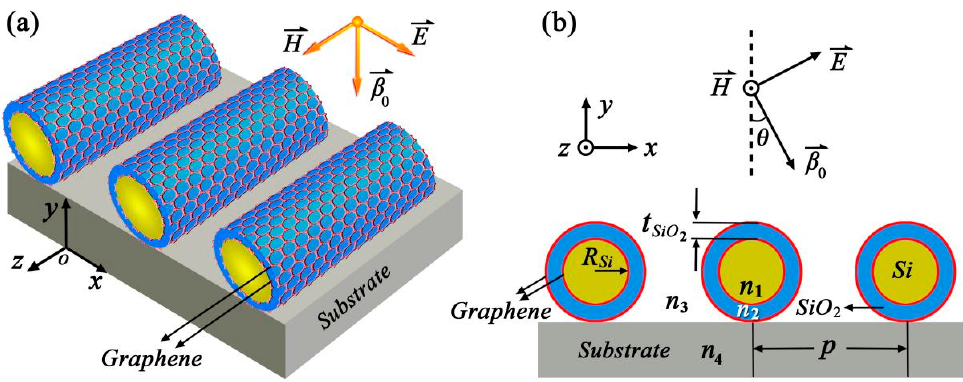
Figure 1. ( a ) Schematic of the proposed grating consisting of the graphene-based cylindrical LRSPP waveguide array. ( b ) Cross-section of the proposed grating.